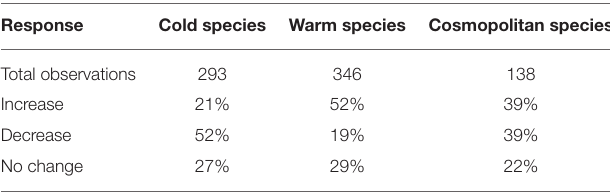
TABLE 1 | Observations of changing abundance in species classified as cold, warm, and cosmopolitan in their thermal